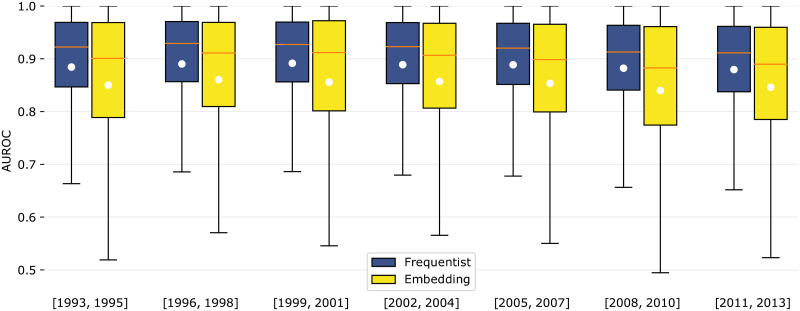
AUROC’s boxplots for scientists’ transitions (various periods).Boxplots of the AUROC for the 0 → A transition for scientists. The orange horizontal line shows the median and the white circles shows the mean. Time windows for both model fitting and density estimation are shown in the x axis (Δϕ = ΔRCA = 2). Time windows for prediction testing begin immediately after the previous ones (Δtest = 2).